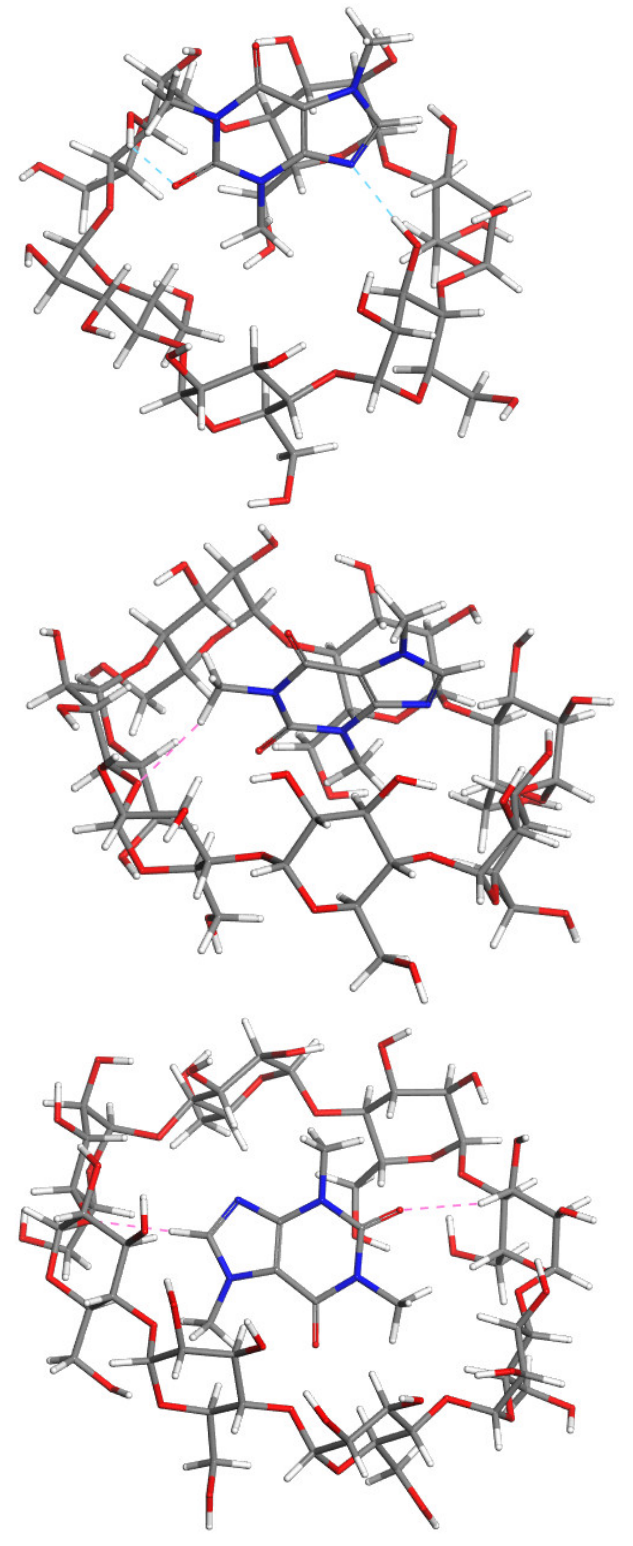
Figure 5. The most stable modeled structures: Caf@α-CD (upper); Caf@β-CD (middle); and Caf@γ-CD (lower). Atoms: C (grey); H (white); O (red); and N (blue). The cyan and pink dashed lines represent possible hydrogen bonds and close contacts stabilizing the complexes, respectively.